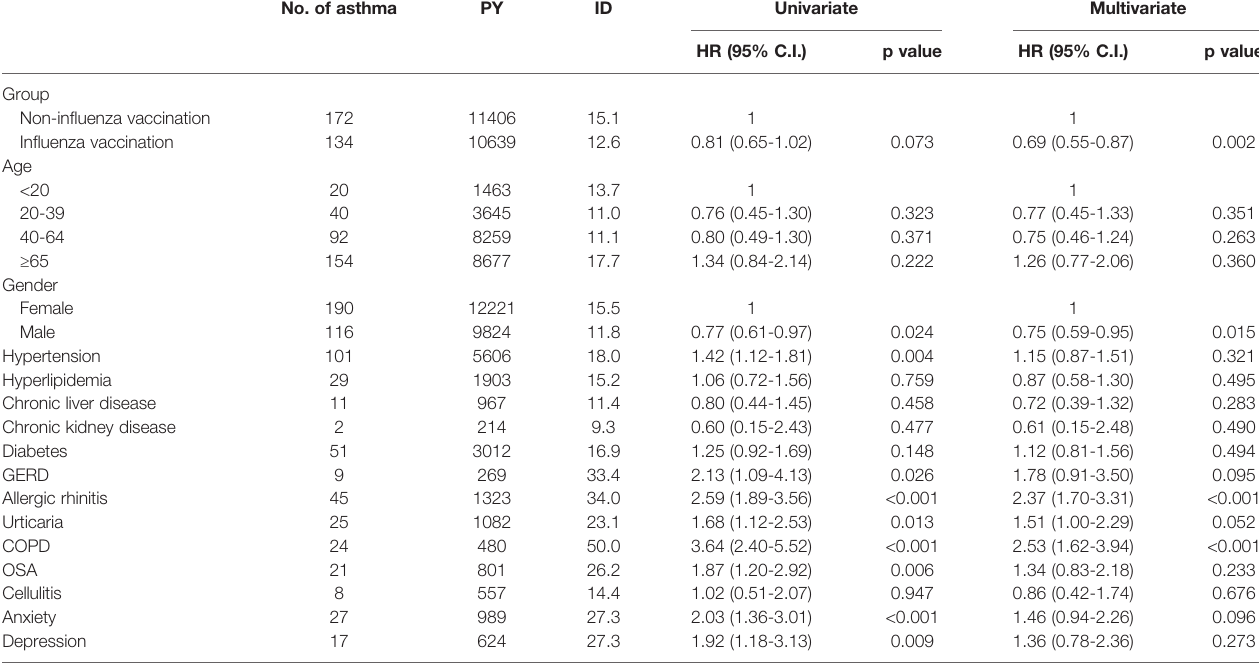
TABLE 2 | Cox proportional hazard model analysis for risk of asthma.